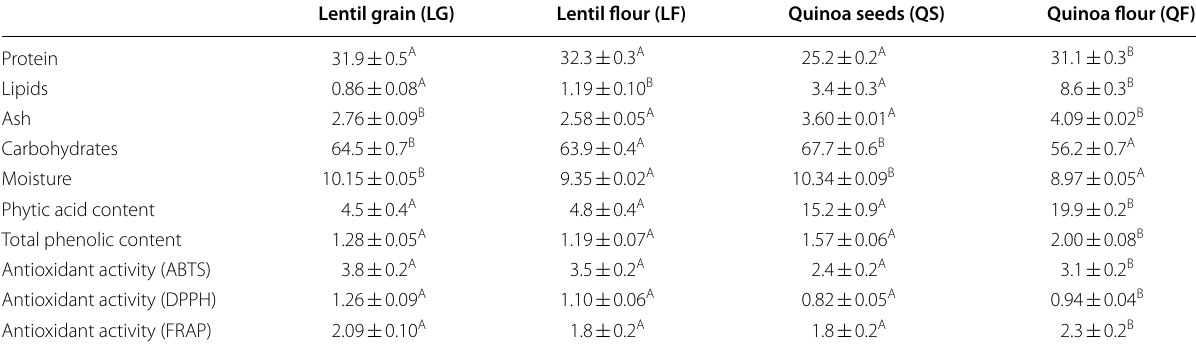
Results are expressed in g/100 g dry basis for proximate composition, mg phytic acid, gallic acid or Trolox/g dry basis, phytic acid content, total phenolic content and antioxidant activity, respectively. They represent the mean of three repetitions with their standard deviation. AB Capital letters indicate significant differences between grain/seeds and flour at the 95% ( p < 0.05) significance level